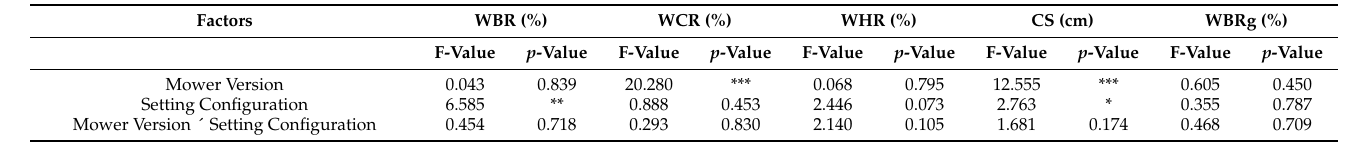
Table 3. F-values and p -values estimations from two-way ANOVA.